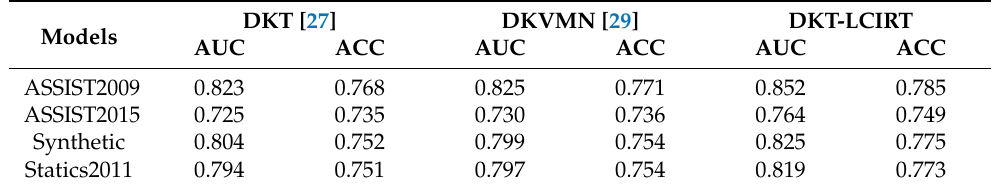
Table 2. Average AUC and ACC values of the three models on all datasets (DKT-LCIRT Model).